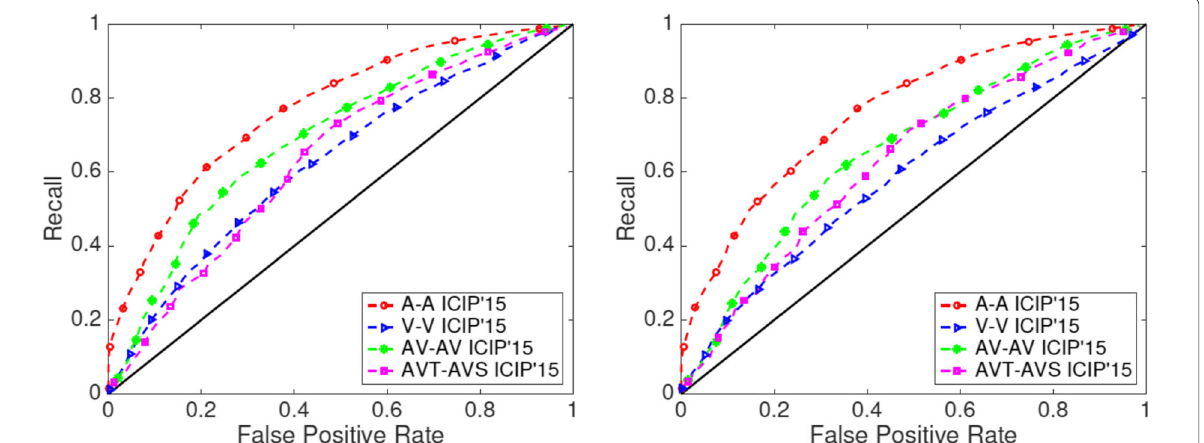
Fig. 12 ObjectiveevaluationresultsforGWW.SaliencyclassificationROCcurvesfor the different modalities for GWW trained in the Hollywood movies ( leftfigure